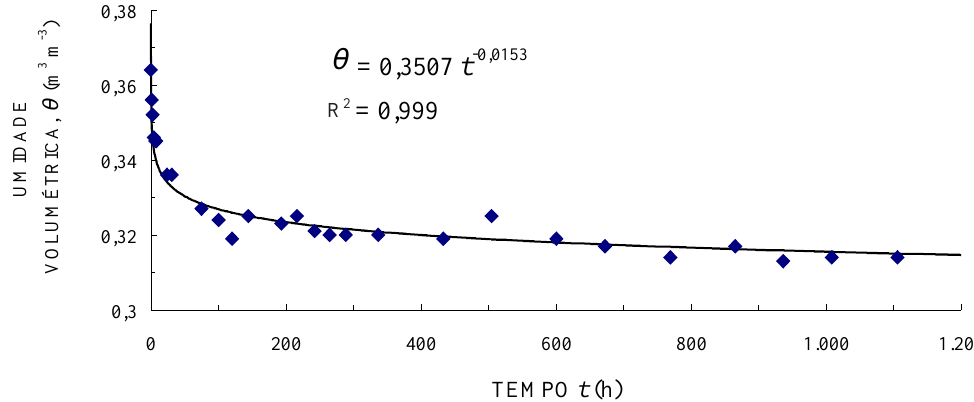
Figura 2. Ajuste à equação 5 dos dados do local 9 e profundidade de 0,8